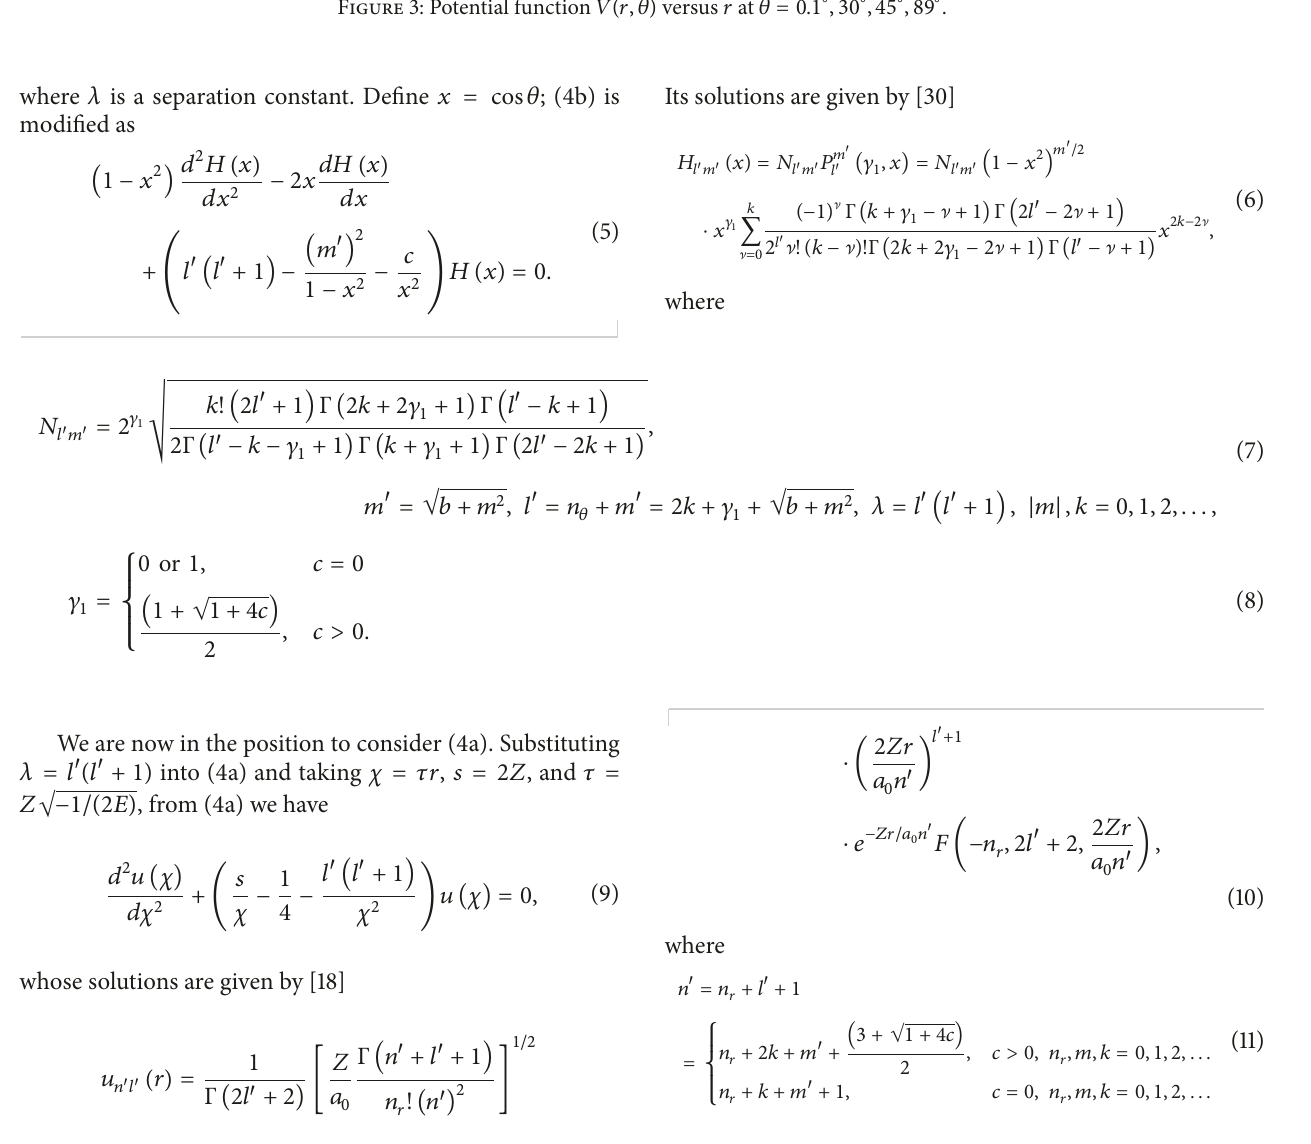
Figure 3: Potential function 𝑉(𝑟, 𝜃) versus 𝑟 at 𝜃 = 0.1 ∘ , 30 ∘ , 45 ∘ , 89 ∘